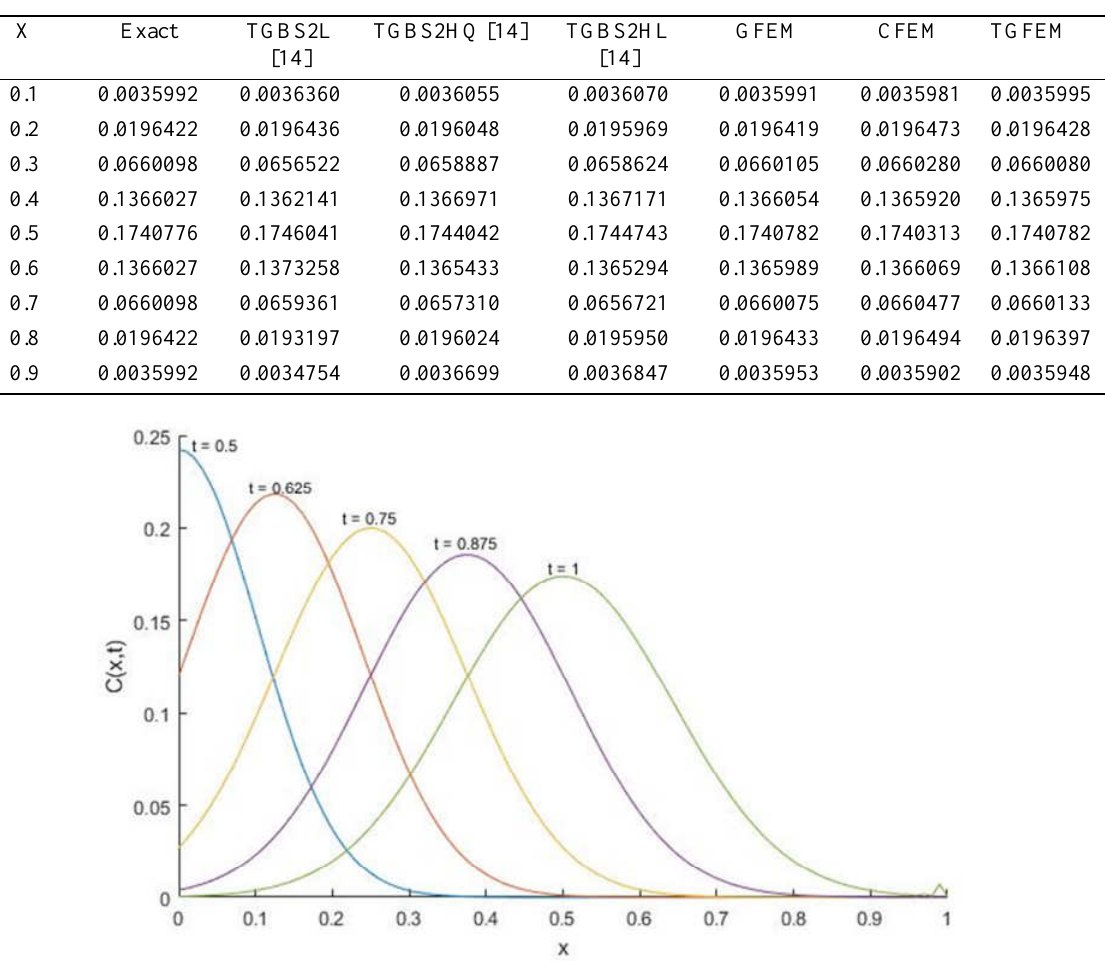
Figure 5 . GFEM solution at various times in Problem 3 for (cid:10) (cid:2) 0.01,(cid:13)(cid:14) (cid:2) 0.001 , (cid:16)(cid:17) (cid:2) 0.1 and (cid:18)(cid:19) (cid:2) 1.